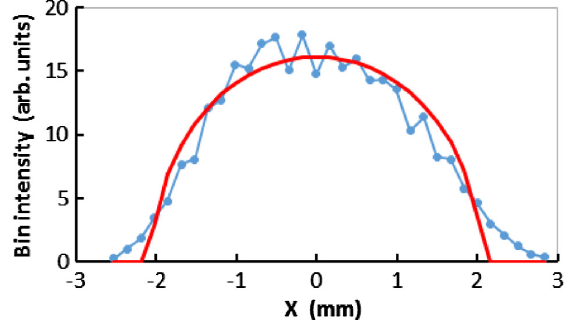
FIG. 9. Comparison of a 1D current density distribution from a back-propagated phase portrait (blue) and a uniform distribution fit